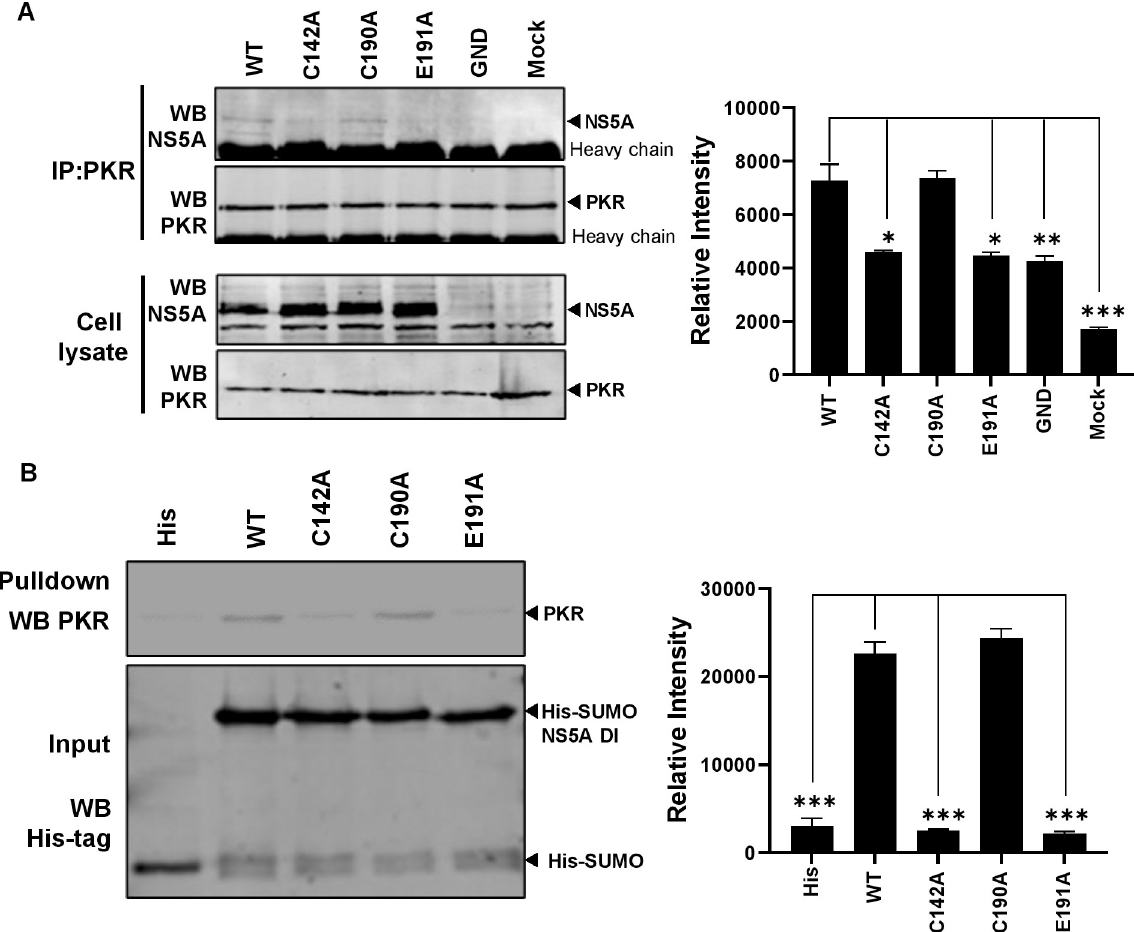
Fig 13. Protein-protein interaction analysis of NS5A and PKR. (A) Huh7.5 cells electroporated with mJFH-1 WT and DI mutants C142A, C190A and E191 were lysed and immunoprecipated with anti PKR antibody ( A ). Immunoprecipitates (top) and lysates (bottom) were analysed by western blot with the indicated antibodies. ( B) His-SUMO tagged NS5A DI and mutants were purified and bound to Dynabead His-Tag beads as a bait to precipitate PKR protein overexpressed in HEK293T cells. Precipitates were analysed by western blotting for PKR (top), and inputs verified by western blotting for the His-tag (bottom). Representative WB are shown. Blots from 3 independent experiments were quantified by densitometry (right hand graphs). Significant differences from WT denoted by � (P < 0.05), �� (P < 0.01) and ��� (P < 0.001).